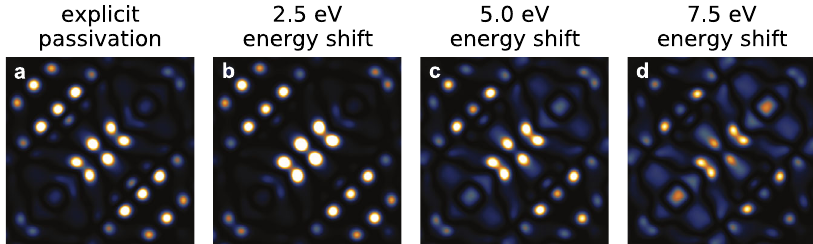
Fig. 1 Effect of passivation method on STM images. Simulated STM images for a single P dopant at depth 4.75 a Si with the STM tip assumed orbital, depending on applied passivation method, with ( a ) explicit passivation, and ( b – d ) implicit passivation for to consist of a single d z 2 (cid:1) 1 3 r 2 various dangling bond shifts. a Si is the Si lattice